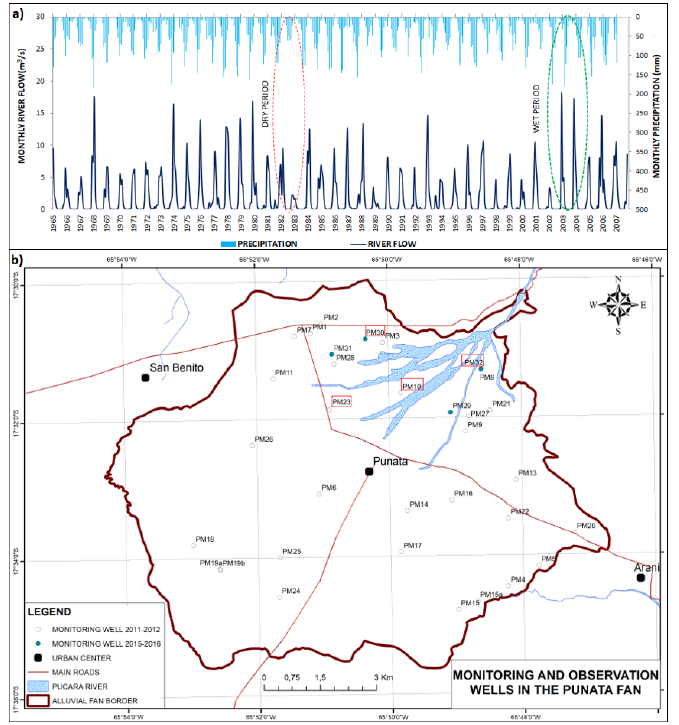
Figure 6. ( a ) Monthly precipitation at the Tiraque station and monthly average river flow at the outlet of the Pucara basin; ( b ) Locations of the groundwater table monitoring wells. Enclosed labels are the boreholes used in Figure 7.